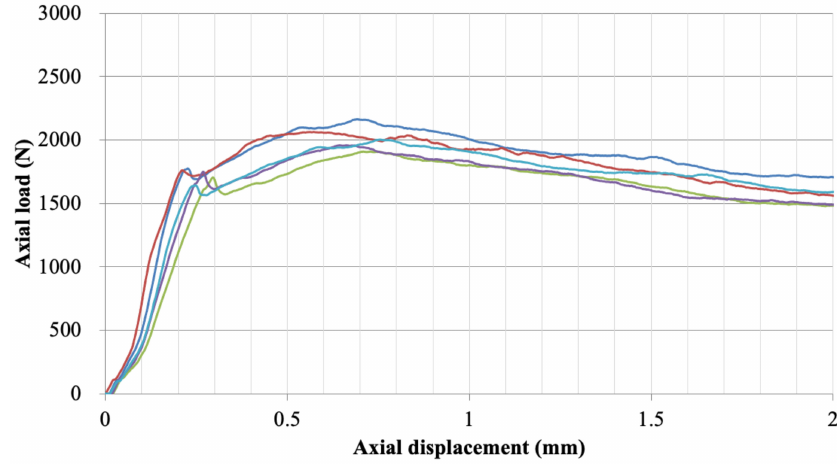
Figure 3. Sample testing curve for axial slip testing showing five test runs for a